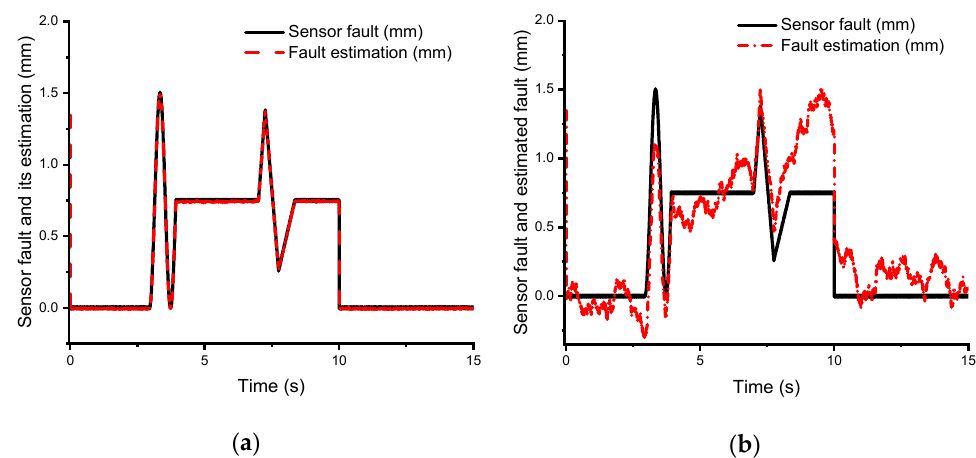
d = , and ( b ) disturbance k